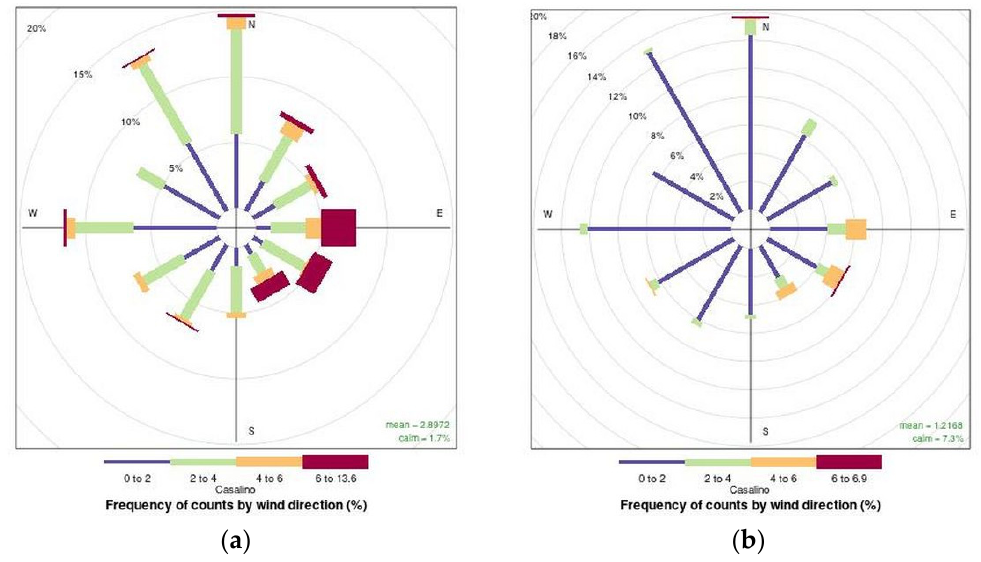
Figure 5. Wind rose of hourly mean values ( a ) and gust ( b ) for the period 1 October 2020–31 October 2020. Spoke’s length represents the frequency of the wind blowing from the identified direction, while the color(s) within the spoke indicate the percentage of counts with the wind speeds for a certain interval.